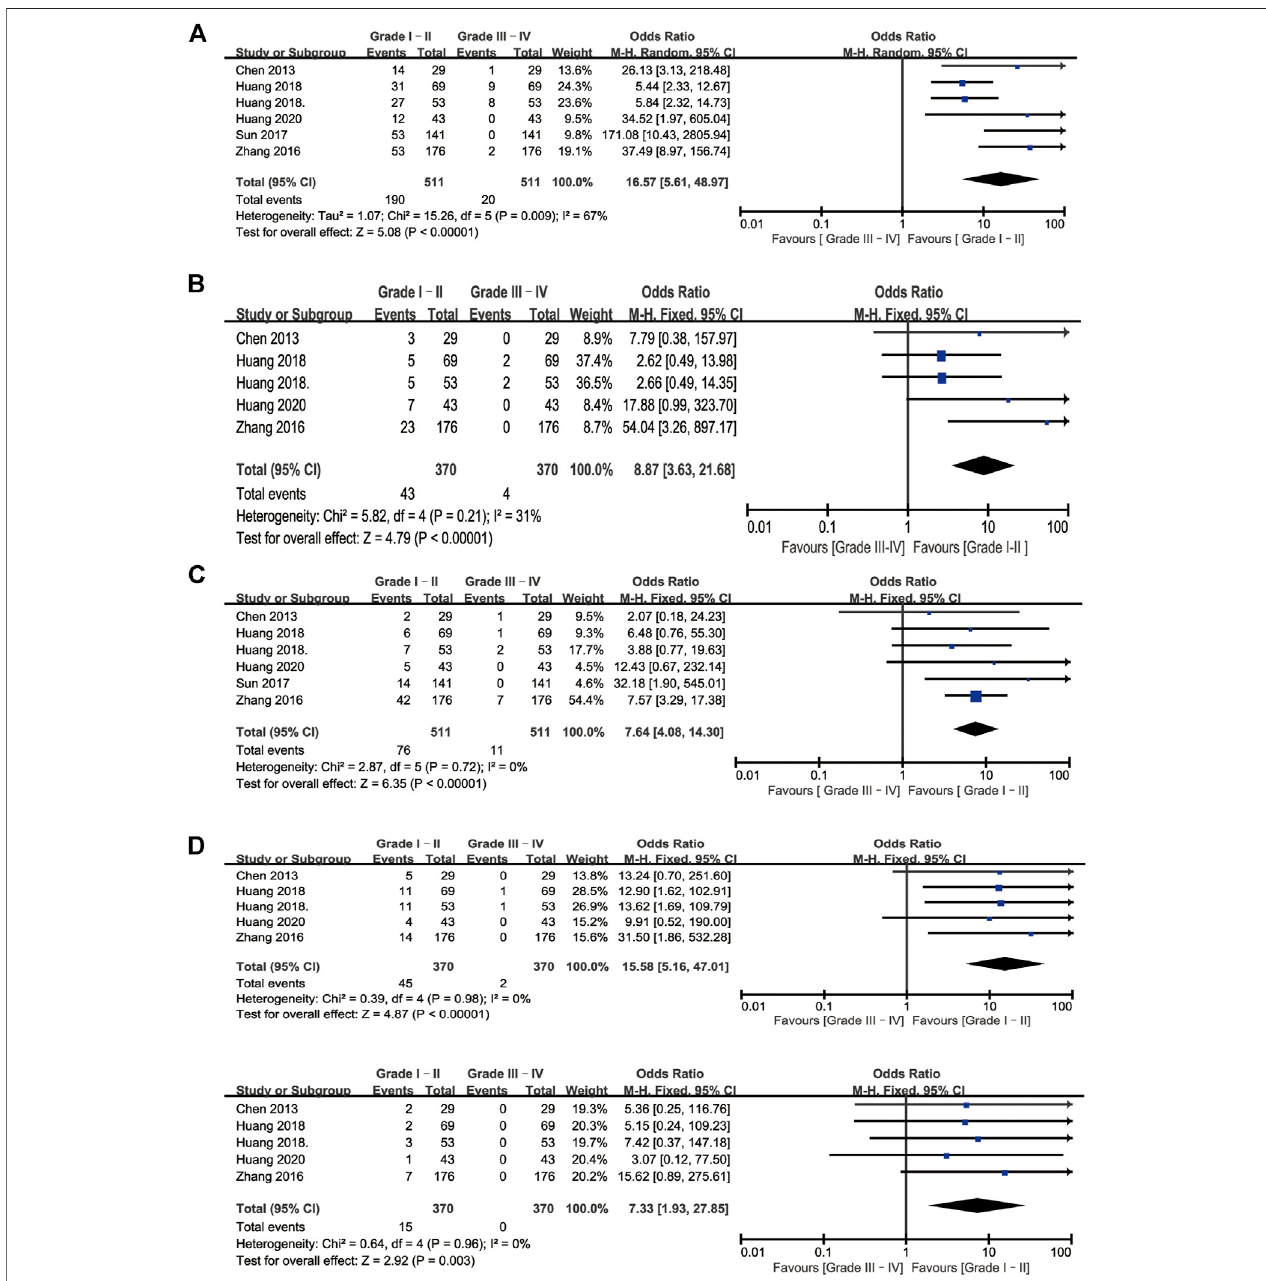
FIGURE6| ForestplotsofcomplicationsassociatedwithIAC. (A) Nausea/vomiting (B) Hypoleukemia (C) Neutropenia (D) Increasedalanineaminotransferase (D) Increased creatinine.